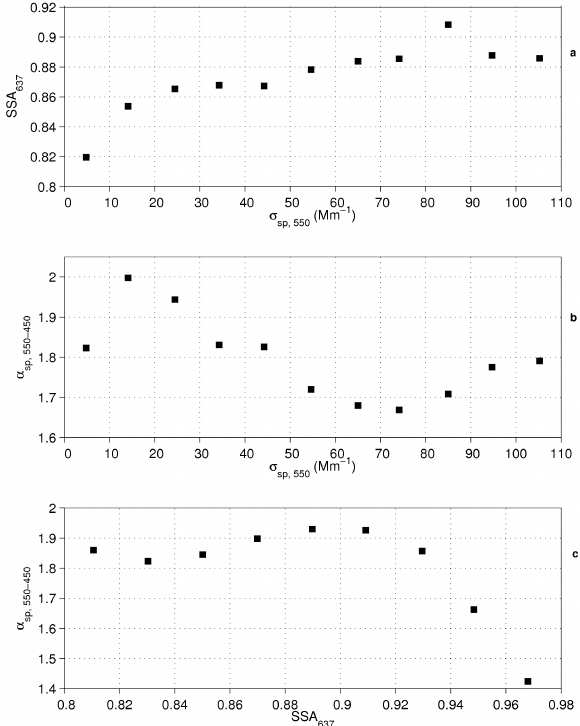
Fig. 5. 737 Fig. 5. (a) Mean single scattering albedo (SSA 637 ) classified ac- cording to 10-Mm − 1 bins of the scattering coefficient at 550nm ( σ sp , 550 ) , (b) mean scattering ˚Angstr¨om exponent between 550 and 700nm classified according to 10-Mm − 1 bins of the scattering co- efficient at 550nm ( σ sp , 550 ) , and (c) mean scattering ˚Angstr¨om ex- ponent between 550 and 700nm classified according to 0.02 bins of the single scattering albedo (SSA 637 )